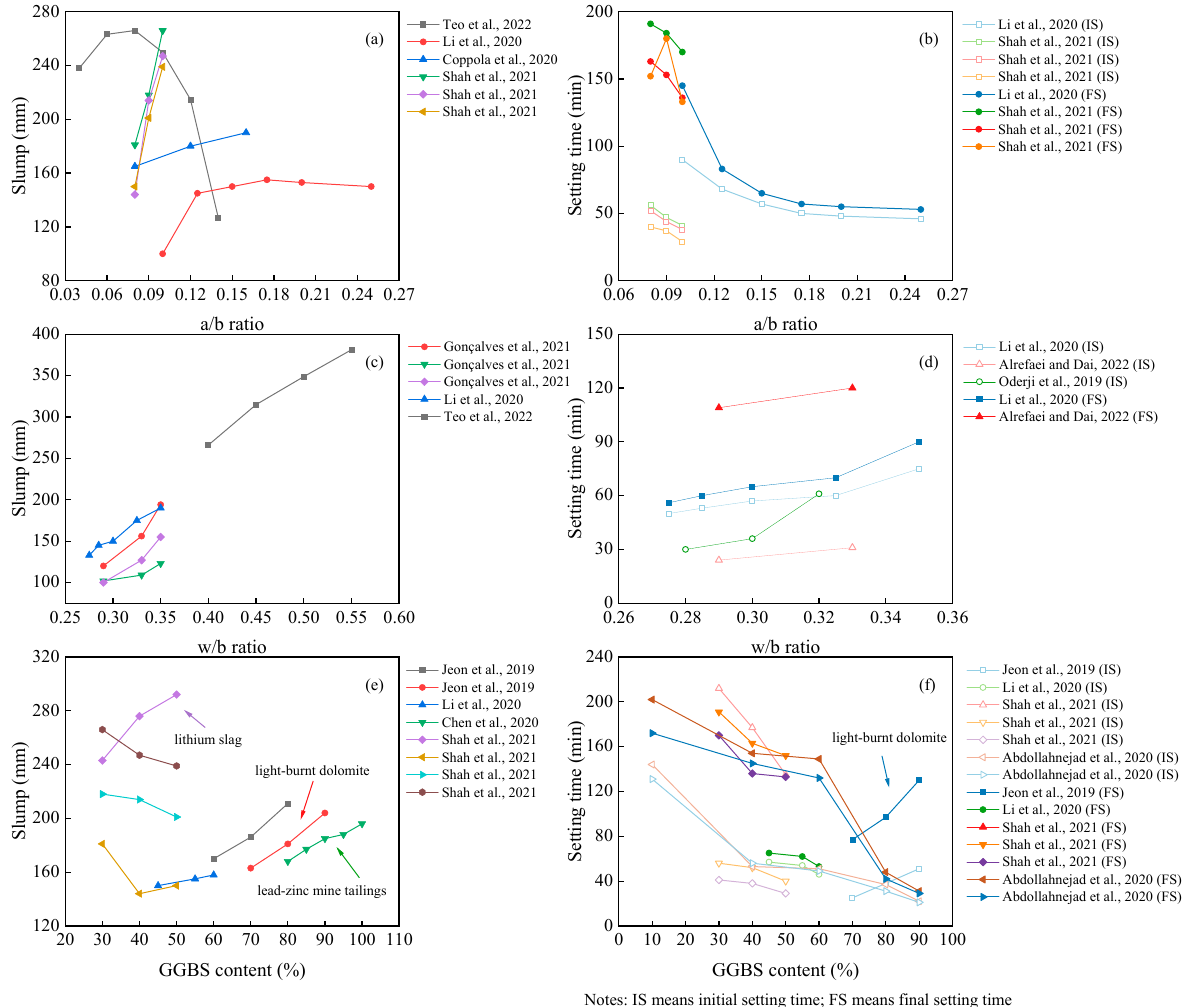
Figure 7. Influence of a/b ratio ( a , b ); w/b ratio ( c , d ); GGBS content ( e , f ) on OP-AAM performance [44,54,61,64,68,80,90,91,93,108].